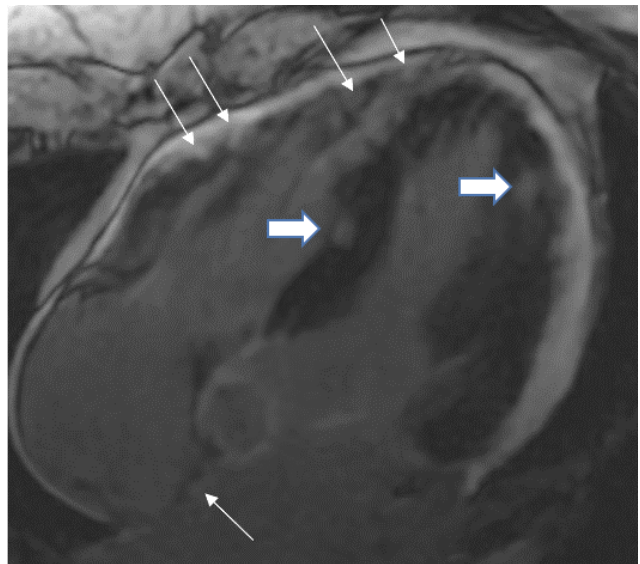
Figure 3. A 35-year-old male with a recent history of treated tuberculous pericarditis for six months had CMR for ventricular tachycardia. 4 CH, late enhancement images, shows RV free wall (epicardial and transmural thin arrows), inferior septal (transmural- thick Arrow), lateral wall LV (transmural-thick arrow), and interatrial septum (thin arrow) enhancement.